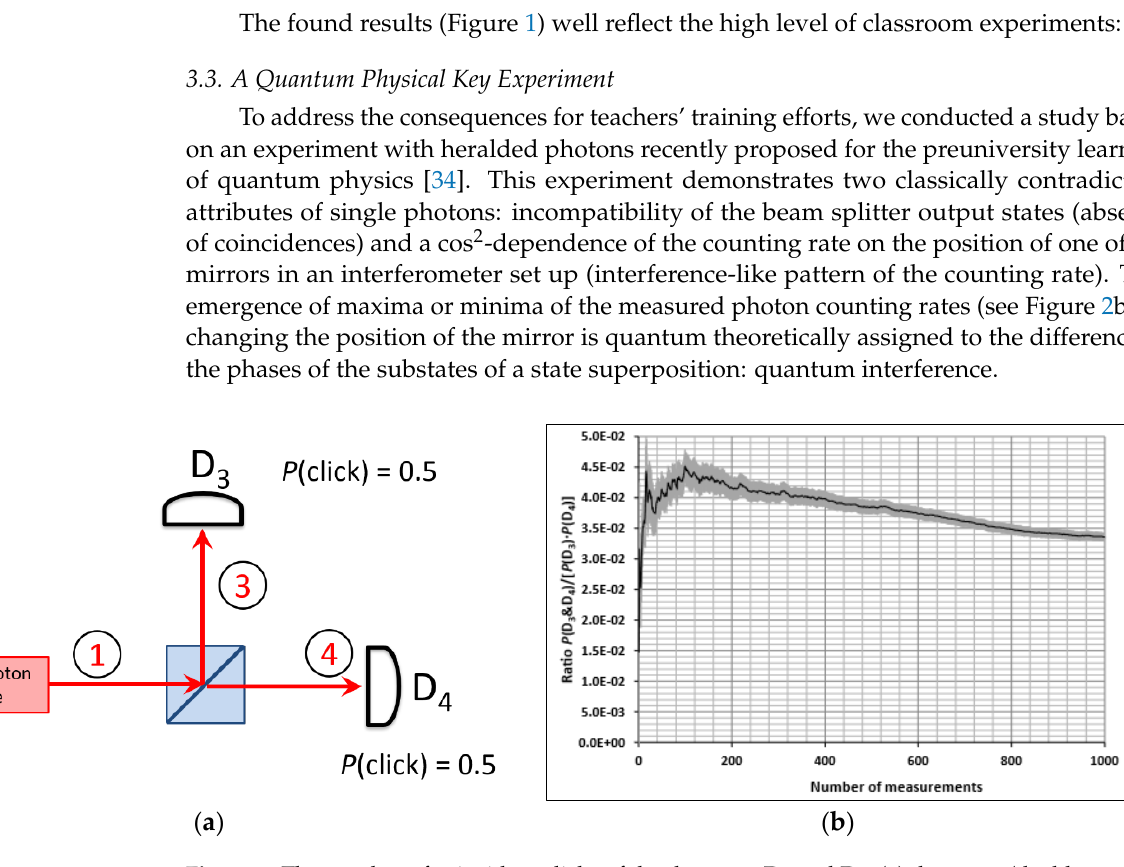
Figure 2. The number of coincident clicks of the detectors D 3 and D 4 ; ( a ) the setup (the blue square indicates the beam splitter, encircled numbers are assigned to the beam splitter modes; red lines indicate the direction of propagation of the light) and ( b ) experimental results: the mean value of 1000 measurements α << 1; the shaded area indicates the standard error. P denotes the probability of a detector click .